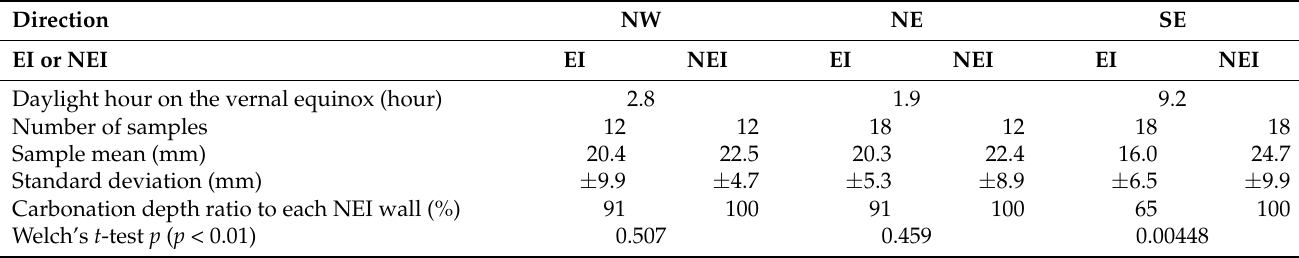
Table 4. Various statistical values for concrete cores in which carbonation is